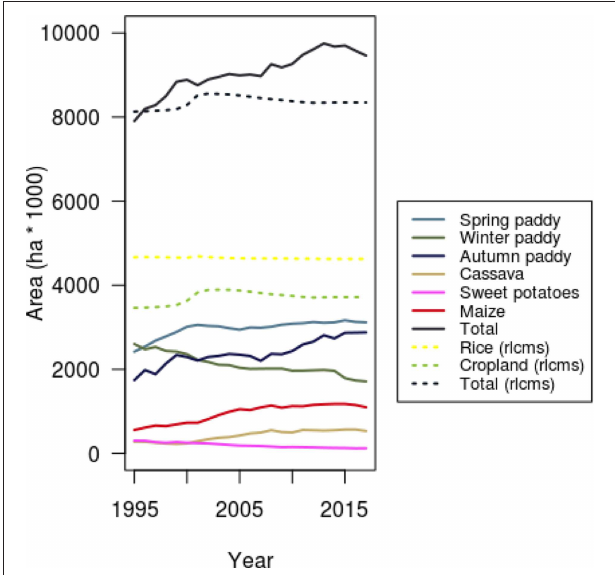
FIGURE 5 | Area from statistical yearbook and area calculated from the RLCMS landcover map.